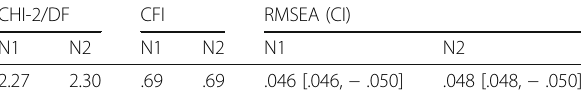
Table 1 Confirmatory factor analysis of the item